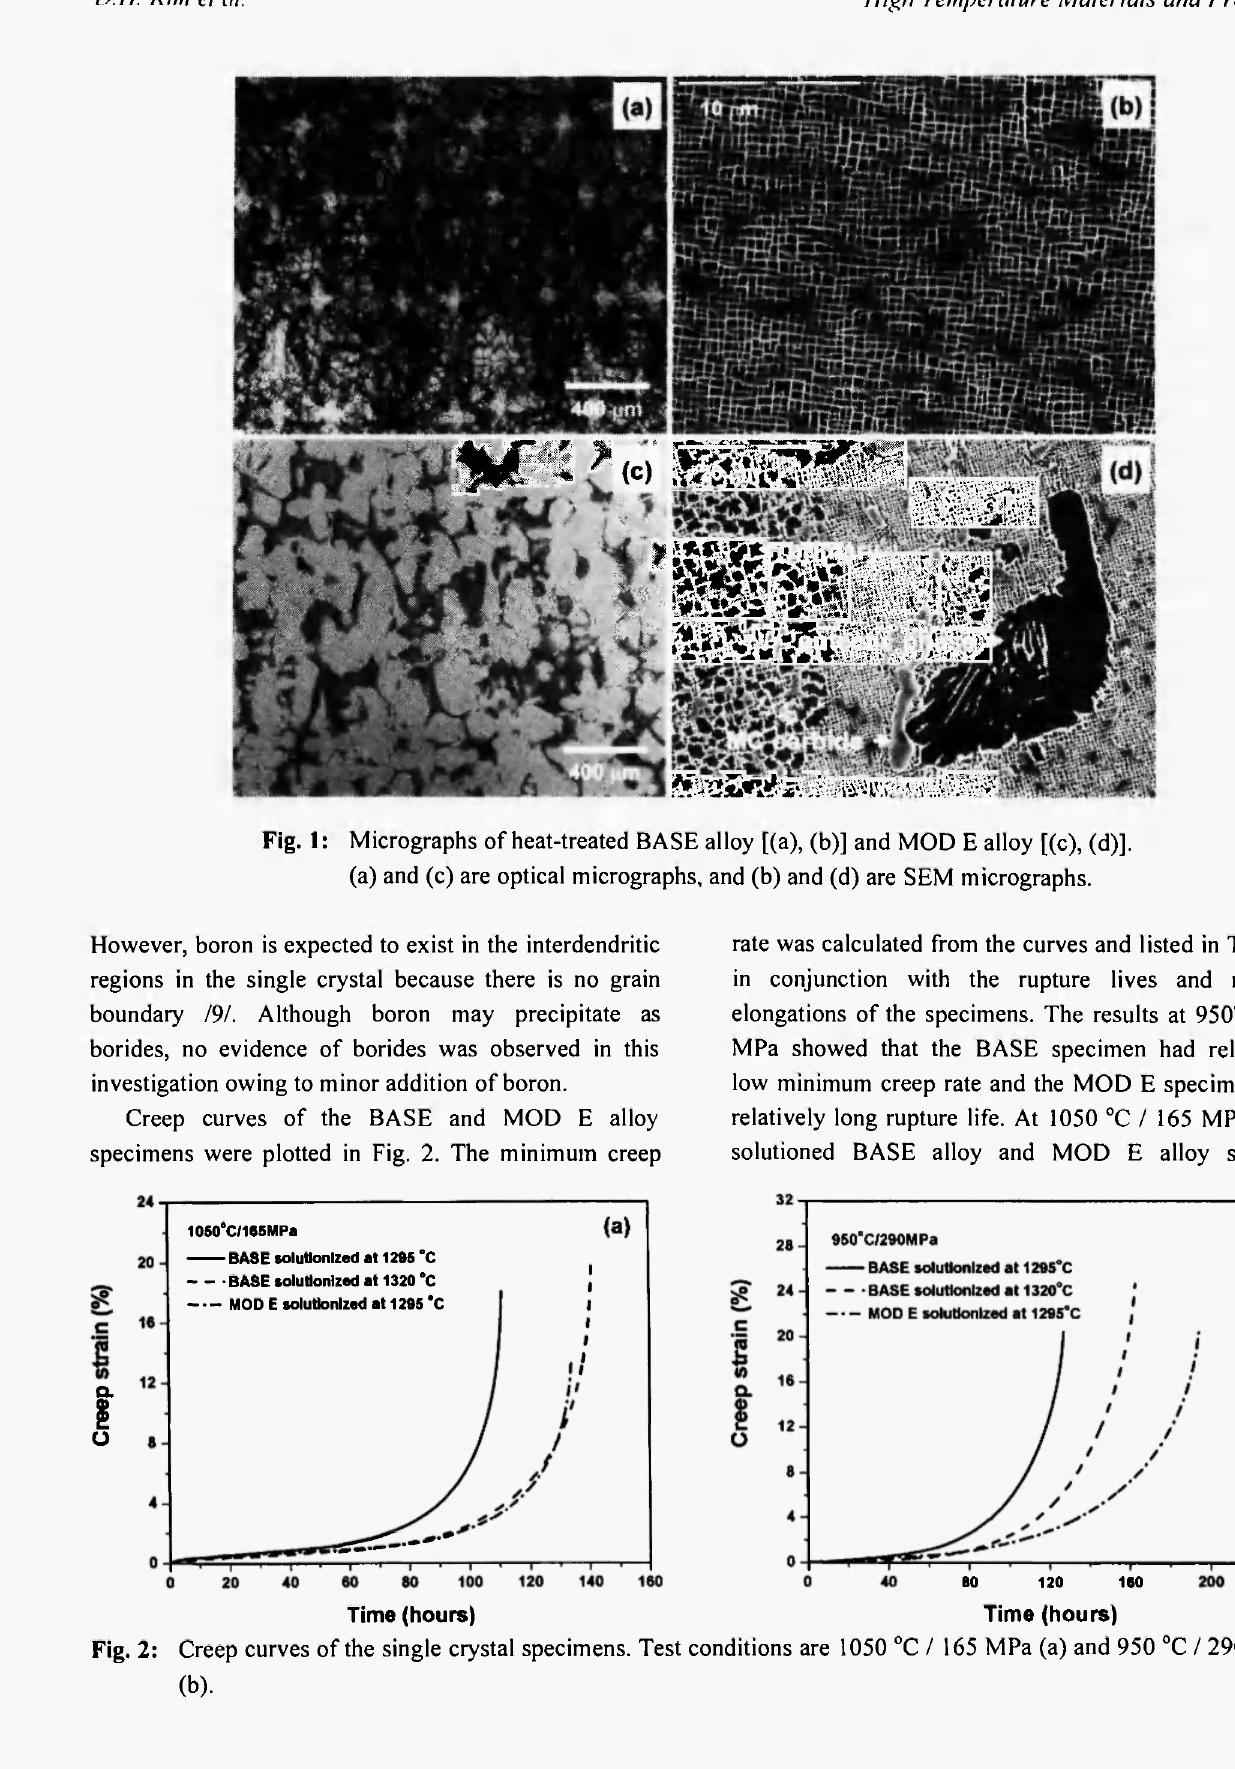
Time (hours) Fig. 2: Creep curves of the single crystal specimens. Test conditions are 1050 °C / 165 MPa (a) and 950 °C / 290 MPa (b).